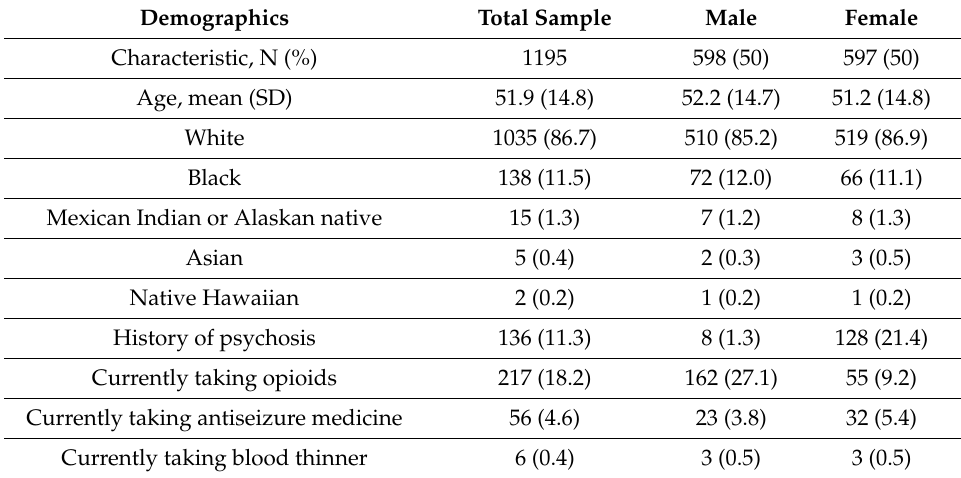
Table 1. Comparison of male and female patients in Louisiana MM